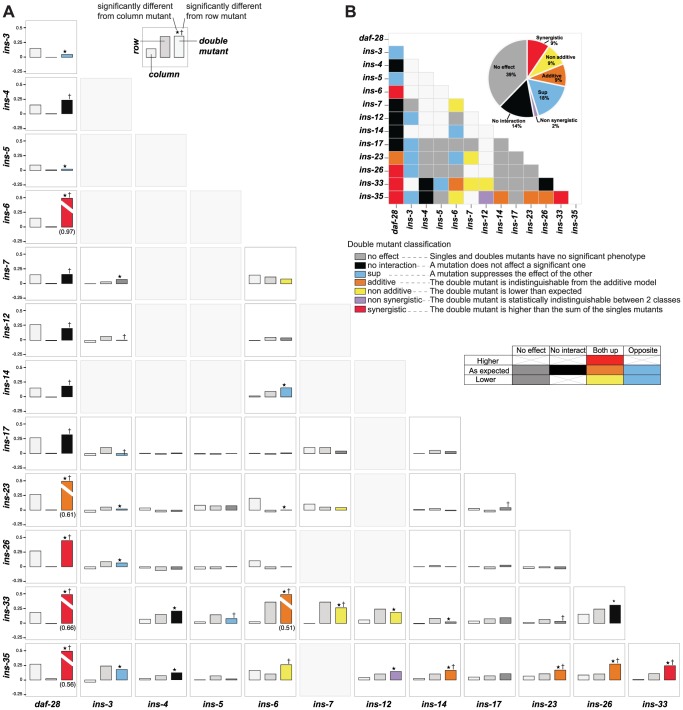
Genetic interactions between ILPs.(A) Double mutant analysis for dauer entry. Bars represent the phenotypes of single and double mutants (legend at bottom right); the class of genetic interaction is colored in the bar for the double mutant. (*) and (†) indicate significant difference with the column and row mutant, respectively (p<0.05, hypergeometric test). (B) Heat map and a pie chart summarizing the different genetic interactions based on dauer entry phenotypes of single and double mutants. Percentages in the pie chart do not add up to 100% due to rounding errors.